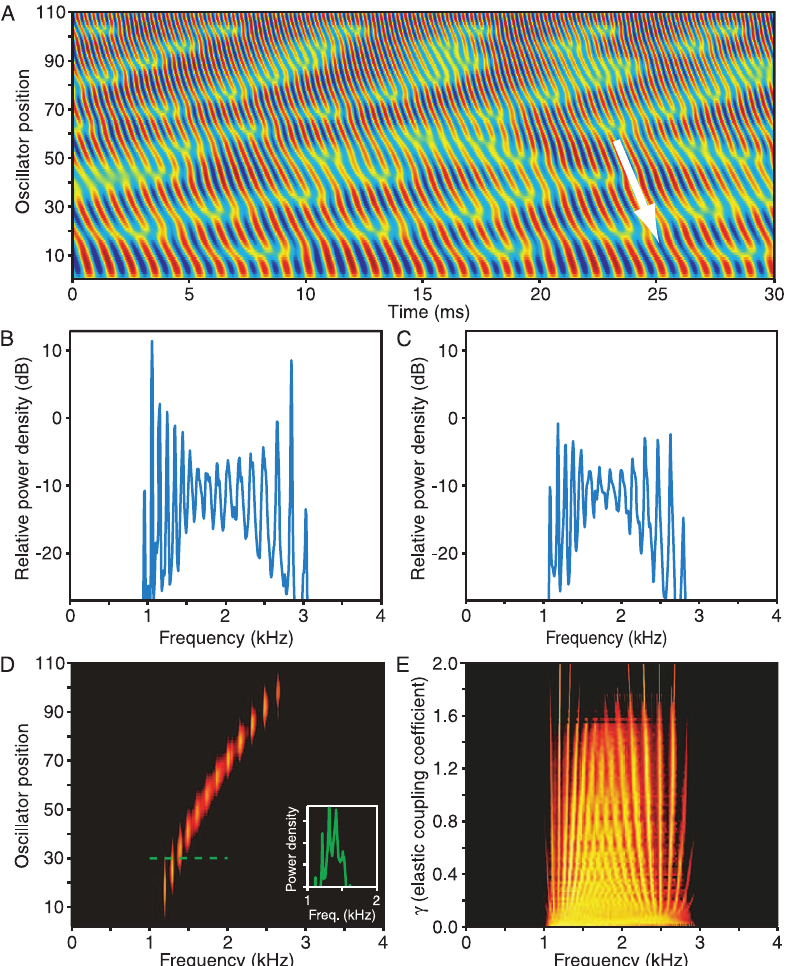
Figure 3. The effect of elastic coupling. A. A spatiotemporal plot portrays waves of synchronization progressing systematically from the high- frequency end of the chain toward the low-frequency end (arrow). Although each oscillator spends most of its time as a component of a group oscillating at a common frequency, the waves are interrupted sporadically by defects as individual oscillators shift from group to group. B. In the power spectrum for elastically coupled oscillators, power is concentrated in 15 central peaks. Each simulation presented in this and the remaining figures covered 3.2 s, divided into overlapping segments of 128 ms. C. A chain in which the amplitude a tapers linearly over the last 18 oscillators at each end yields a power spectrum in which the peaks near the margins are sharper than those near the center. The variation is less pronounced than in (B), however, and more closely resembles that in experimentally recorded spectra. D. Vertically layered power spectra for the 110 individual oscillators indicate that each contributes power to multiple peaks as it shifts its affiliation over time. Colors encode the power-spectral density at each frequency for each oscillator, with brighter areas indicating an increase in density. The inset portrays the power spectrum for the single oscillator indicated by the dashed line. E. Increasing the elastic coupling strength from the bottom power spectrum toward the top causes a progressive reduction in the number of oscillating groups and a sharpening of the group boundaries.